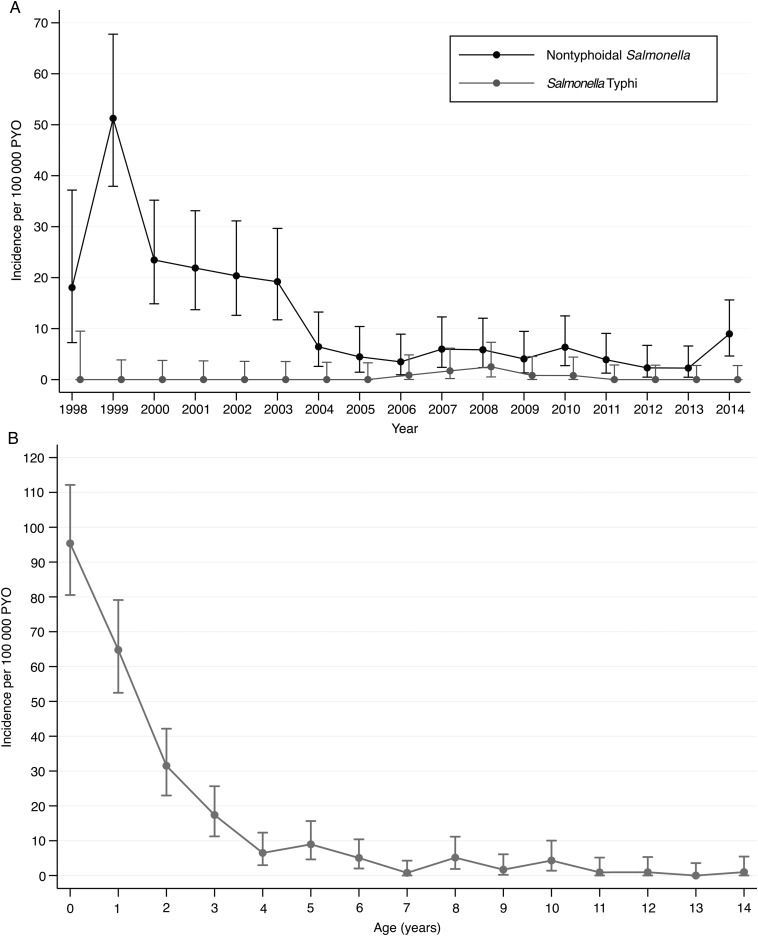
A, Crude incidence (and 95% confidence intervals [CIs]) of nontyphoidal (NTS) bacteremia among children (<15 years) across the study period. B, Crude age-incidence curve (and 95% CIs) of NTS bacteremia among children.